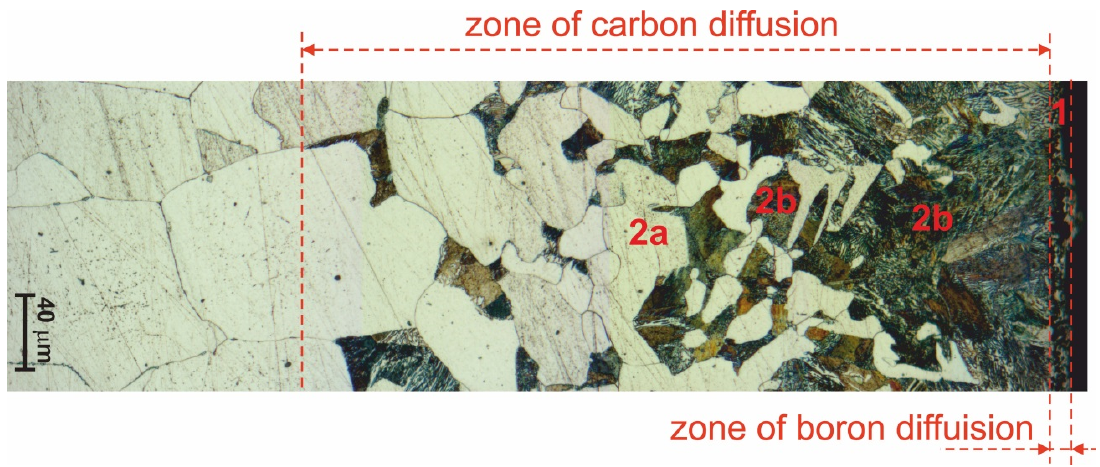
Figure 4. Optical microscope (OM) image of gas borocarburized Armco iron in N 2 –H 2 –B(CH 3 O) 3 atmosphere at 1223 K (950 °C) for 2 h; 1—Fe 2 B iron borides, 2a—pearlite, 2b—ferrite.